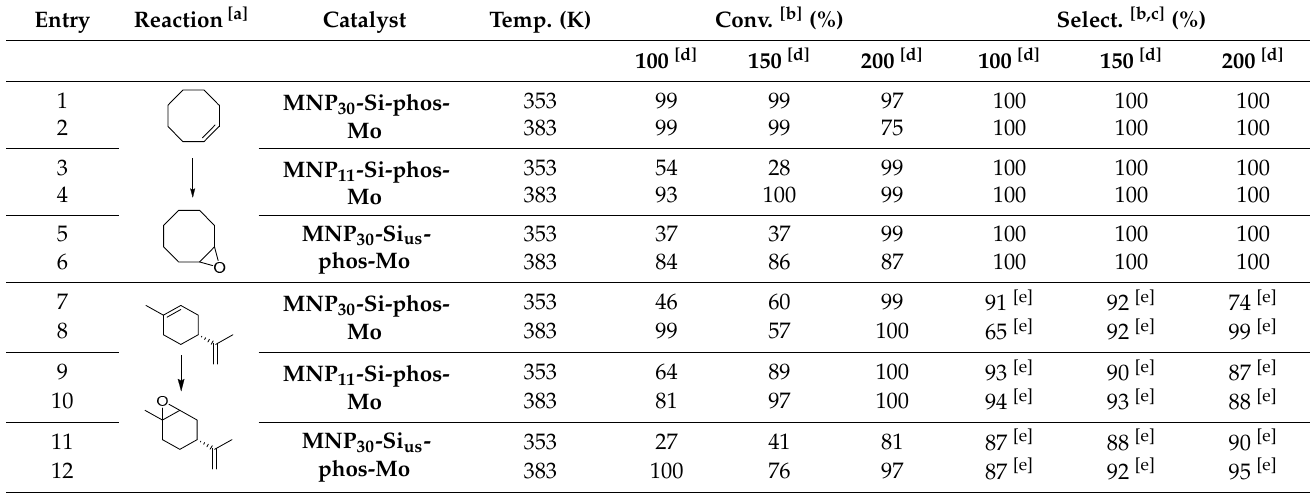
In the epoxidation of R -(+)–limonene, the catalytic system’s performance followed the same trend by reaching higher substrate conversion at 200 mol% tbhp ratio. Catalyst